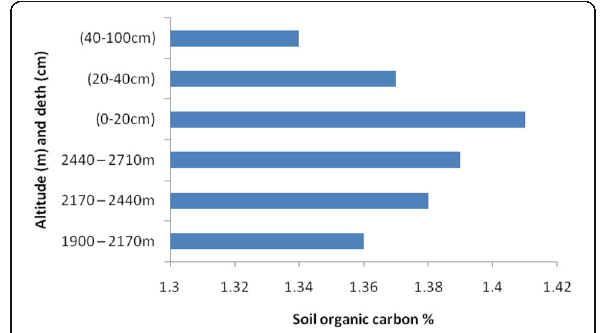
Fig. 5 Variation of SOC (%) in three altitudinal ranges and soil depths